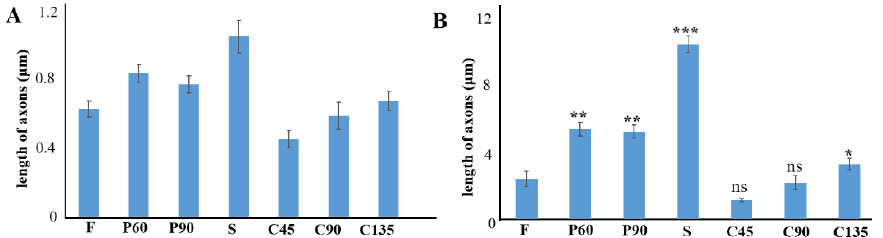
Figure 6. (A ) Histogram of axon length of PC12 cell on different topographies after 6-OHDA treatment without NGF. ( B ) Histogram of axon length of PC12 cell on different topographies after 6- OHDA and NGF treatment. NGF: 100 ng/mL. 6-OHDA: 20 ng/mL. * p < 0.05, ** p < 0.01, *** p < 0.001. The data was the mean value of each parameter for each experimental condition.